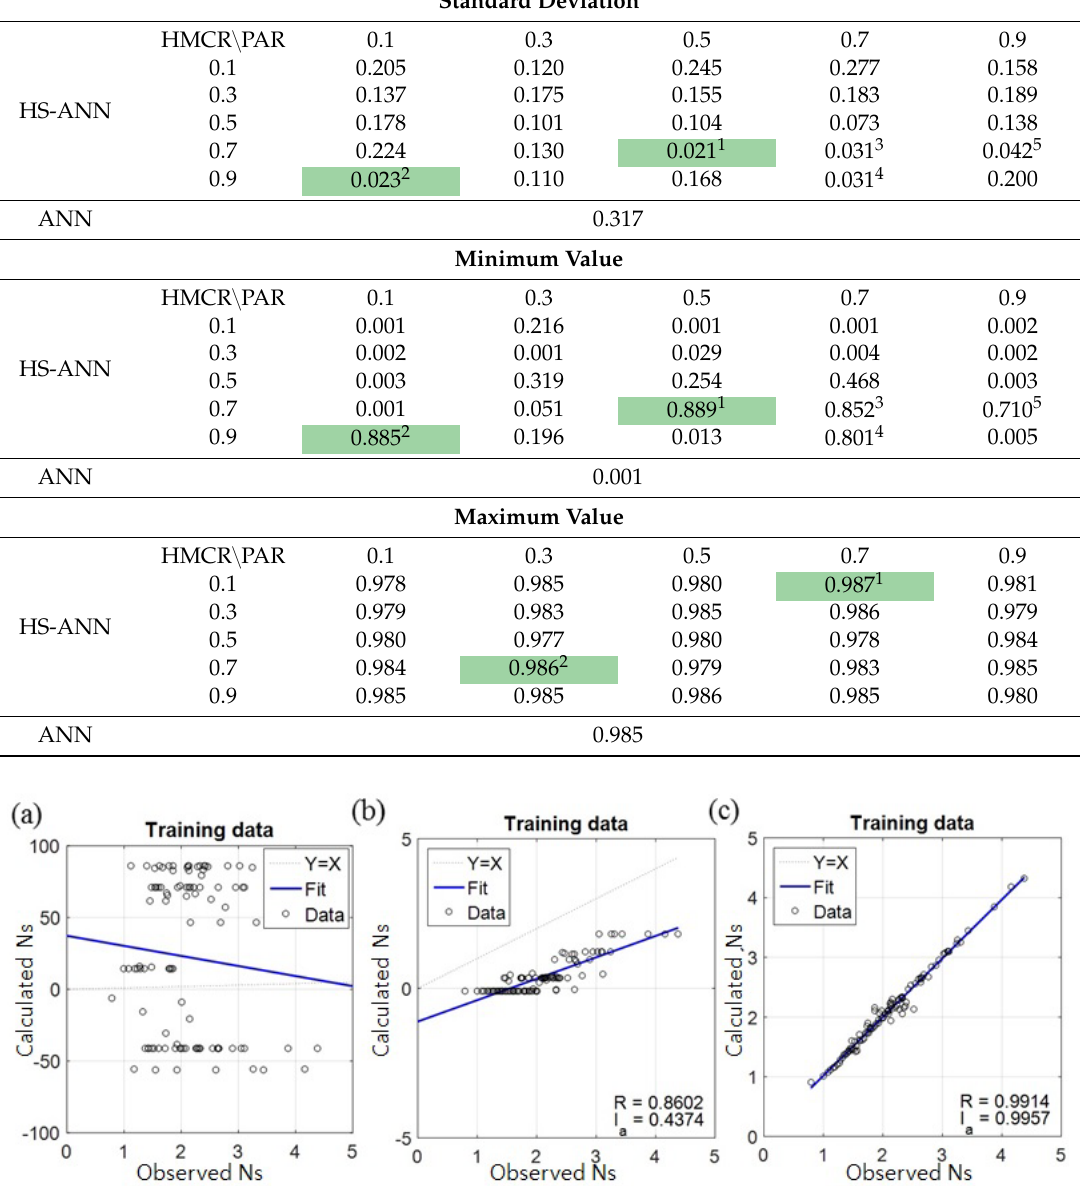
Figure 8. Same as Figure 7 but for Case 2 (HMCR = 0.1; PAR = 0.5). The first graphs in Figures 7 and 8 show that the stability numbers calculated by using the randomly selected initial weights are distributed in a wide range from large negative values to large positive values and have very weak and negative correlation with the observed stability numbers. The second graphs show that the stability numbers calculated by using the optimal initial weights determined by the HS algorithm are distributed within the range of 0 to 5 as they are in the observation. Case 1 shows much better correlation between calculation and observation than the Case 2, whereas the index of agreement of Case 1 is only slightly better than that of Case 2. The calculated stability numbers in Case 1 show strong correlation with the observed ones, but they are underestimated as a whole. The third graphs after further training by the BP algorithm show very strong correlation and good agreement between calculation and observation. Even Case 2 (the worst case) shows quite high value of index of agreement compared with the values for HMCR = 0.1 and PAR = 0.5 in Table 5. Note that the results in Figures 7 and 8 are for training data, whereas those in Table 5 are for test data. 4.3. Computational Time Most of the computational time of the conventional ANN model is used for the BP training of the model, whereas the HS-ANN model needs computational time for finding the optimal initial weights using the HS algorithm and then for finding the global minimum of the error function by the BP training. Lee [31] compared the computational time between the conventional ANN model and the HS-ANN models with various combinations of HMCR and PAR. Since the statistical characteristics of computational time do not show a big difference among different combinations of HMCR and PAR, here we only present the case of HMCR = 0.7 and PAR = 0.5 for which the HS-ANN